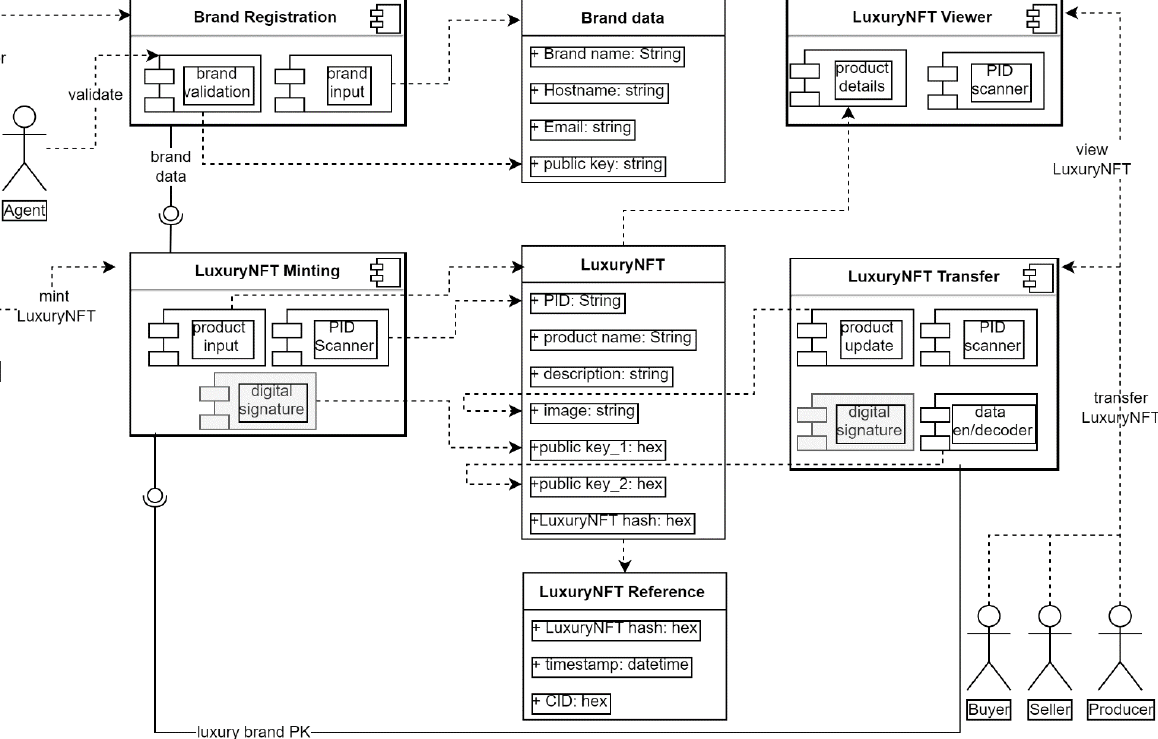
Figure 4. Architecture and data structure of